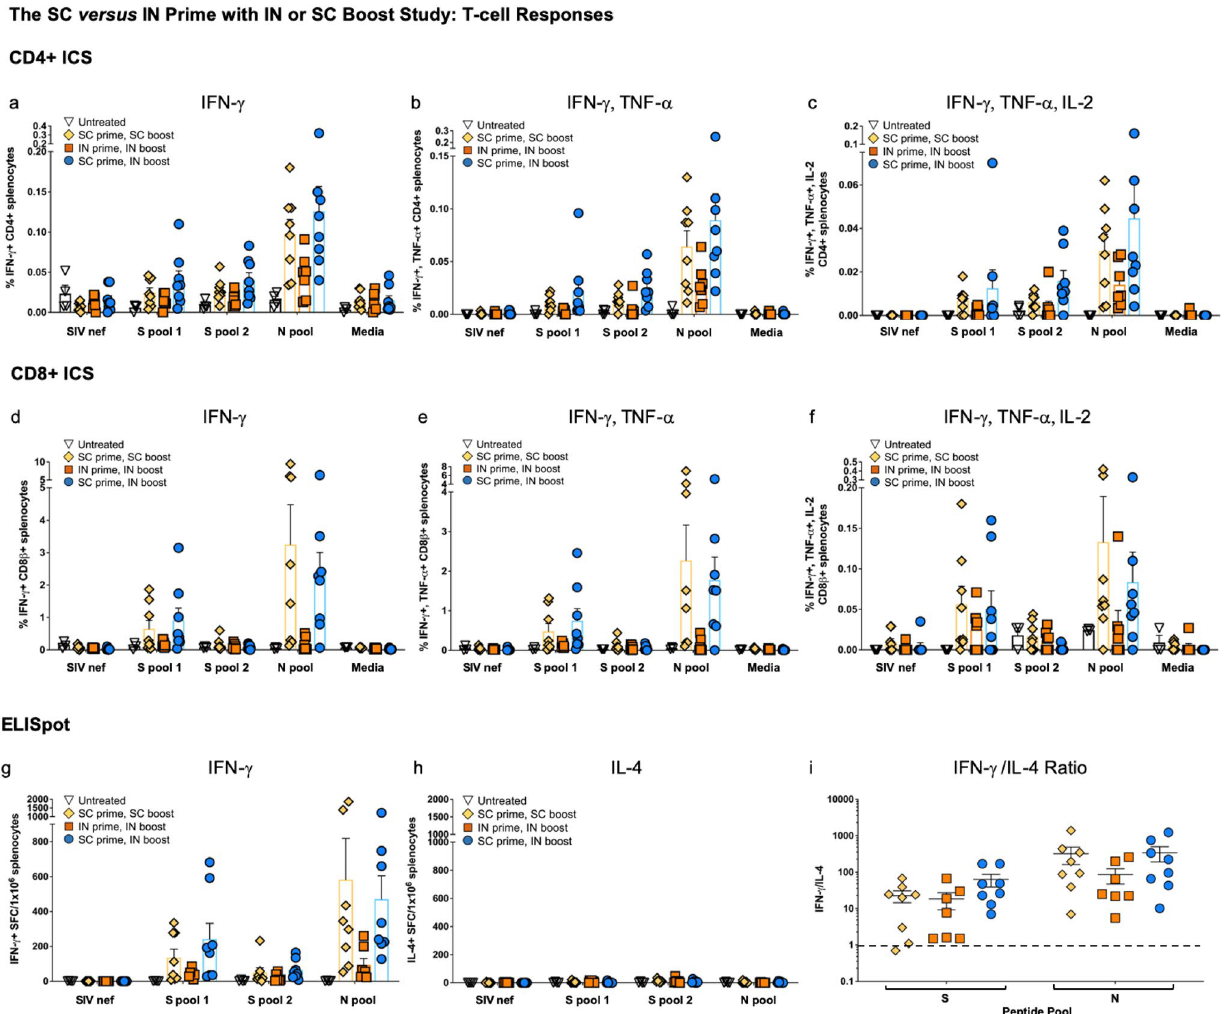
Figure 5. Both CD4 + and CD8 + T cells respond to nucleocapsid peptides in the SC versus IN prime study with SC or IN boost . ICS of IFN-γ; IFN-γ/TNF-α; and IFN-γ/TNF-α/IL-2 in response to S peptide pools 1 and 2 as well as the N peptide pool for CD4 + ( a–c ) and CD8 + ( d – f ) T cells is shown. Some outliers by the Grubb’s test were removed. SIV nef and media are negative controls. ELISpot for ( g ) IFN-γ and ( h ) IL-4 secretion in response to the peptide pools is shown. SIV nef is a negative control. ( i ) The IFN-γ/IL-4 ratios of > 1 (dashed line) show Th1 bias. Statistical analyses performed using One-way ANOVA with Dunnett’s post-hoc comparison of each treatment group to untreated for each peptide pool was performed but did not reveal statistically significant differences due to individual variation among mice. For untreated n = 4, SC > SC n = 8; IN > IN n = 7, and SC > IN boost n = 8. Data graphed as the mean with